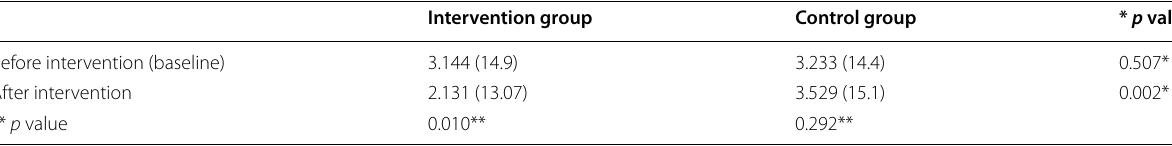
*Independent samples T test